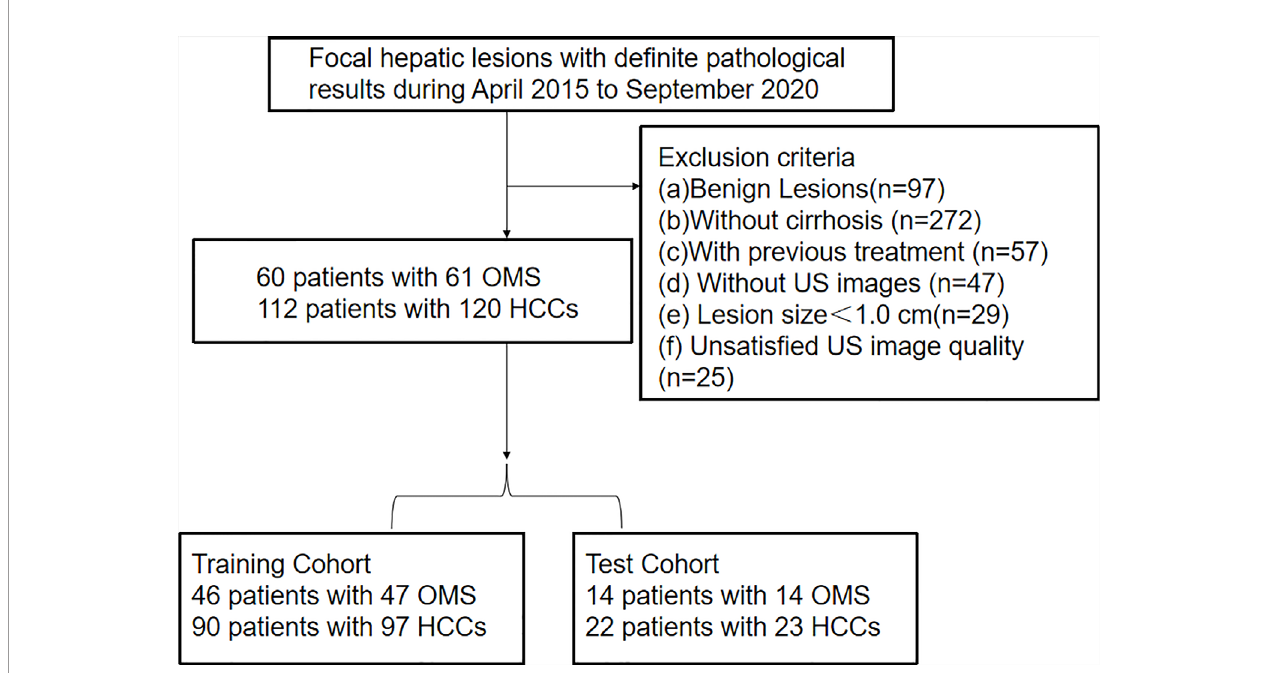
FIGURE 1 | Flowchart of patient selection for differentiating hepatocellular carcinoma and other malignancy in c4irrhotic liver. Clin, clinical features; DLM, deep learning model; LR-M, liver imaging and reporting system